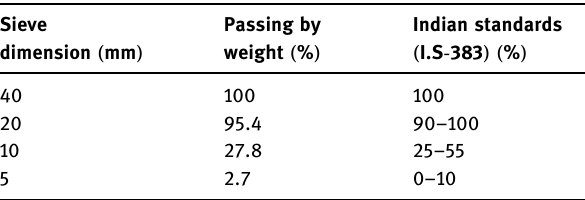
Table 4: Coarse aggregate sieve analysis for normal and waste tile aggregates